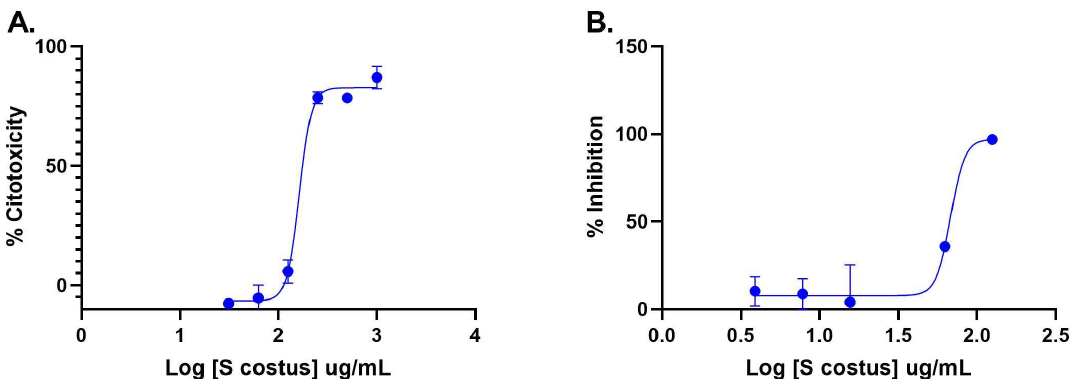
Figure 4. Anti-herpetic activity and cytotoxicity of Saussurea costus extract. ( A ) Vero cells were incubated with increasing concentrations of the acetic extract, and after 72 h, the cytotoxicity was measured as described in the Materials and Methods. ( B ) Vero cells were infected at MOI 1.5 with HSV-1 and incubated with increasing concentrations of the extract. After 48 h, the virus genome was quantitated in the supernatant via qPCR. The percentage of inhibition was determined as the ratio between treated and untreated infected cells. Data are expressed as mean +/− SD for n = 2. In a previous study, the antiviral activity of the aqueous extract of S. costus (EC50 = 1.35 mg/mL, CC50 = 4.92 mg/mL, and SI = 3.6) was reported. In the present work, a similar behavior was observed with the S. costus acetic extract (EC50 = 82.6 mg/mL, CC50 = 162.9 mg/mL, and SI = 1.9). However, a difference in the mechanisms of action of the extracts was observed. The aqueous extract only showed post-entry antiviral activity, whereas the acetic extract also inhibited the virus in the pre-infection condition. This result suggests that the acetic extract also induced an antiviral state in cells.